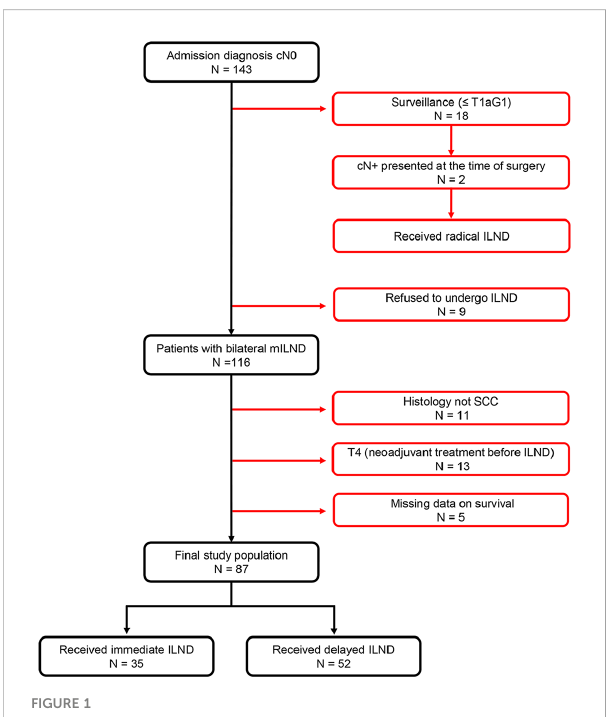
FIGURE 1 Patient enrollment fl